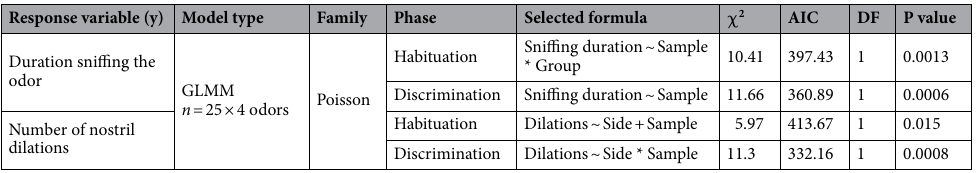
Table 2. Model selection results for each phase.